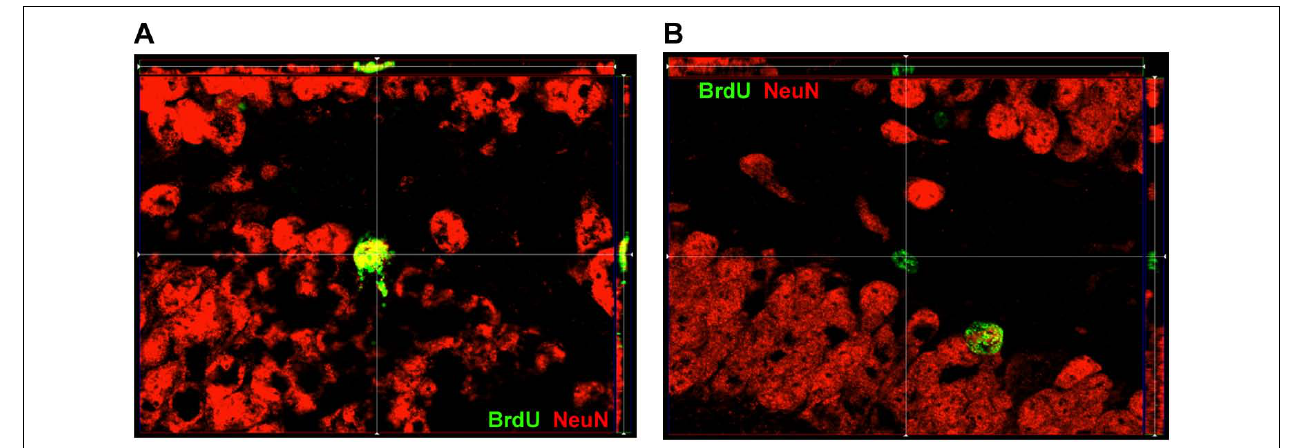
FIGURE 2 |ApoTome image of localization of BrdU and NeuN within DG. (A) Representative image of a cell within SGZ that is BrdU+ and expressed NeuN as well. (B) Representative image of a cell within SGZ that is BrdU+ but does not express NeuN.